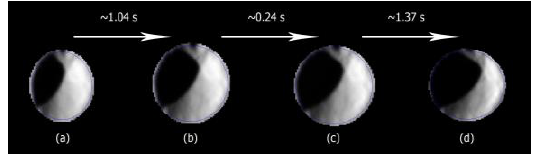
OSIRIS camera position relative to the Lutetia asteroid and the light source).